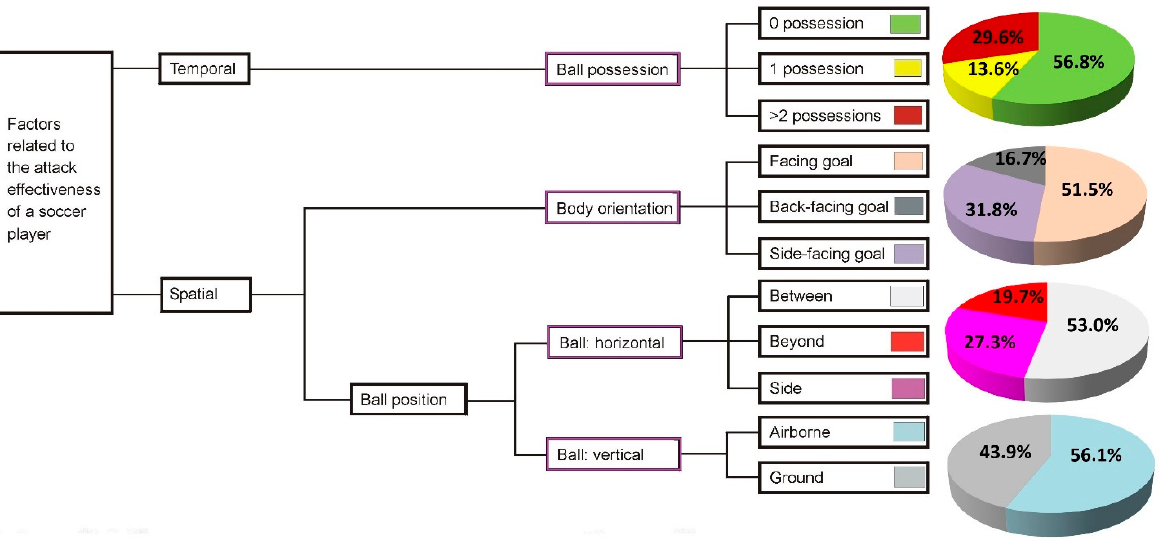
Figure 2. The temporal and spatial factors related to goal chance identification and their contributions to goals: evidence drawn from all 132 FIFA Puskás Award nominees’ goals, 2009–2021. The results of the spatial analysis of the 132 Pusk á s goals denoted that, as a ball comes into an athlete’s proprioceptive shooting volume, a player’s body orientation can be facing, side-facing, or back-facing (Figures 1 and 2) relative to the position of the goal. In terms of body orientation, at the moment of shooting among the 132 Pusk á s goals, about half (51.5%) were achieved facing the goal, while 31.8% were “side-facing”, and 16.7% were “back-facing” (Figure 2). The statistics for horizontal ball position are comparable, with 53.0% of goals having occurred when the ball was between the player and goal, while side and beyond balls accounted for the remaining 47.0%. Regarding vertical ball positioning, 56.1% of the goals were airborne, and only 43.9% were ground